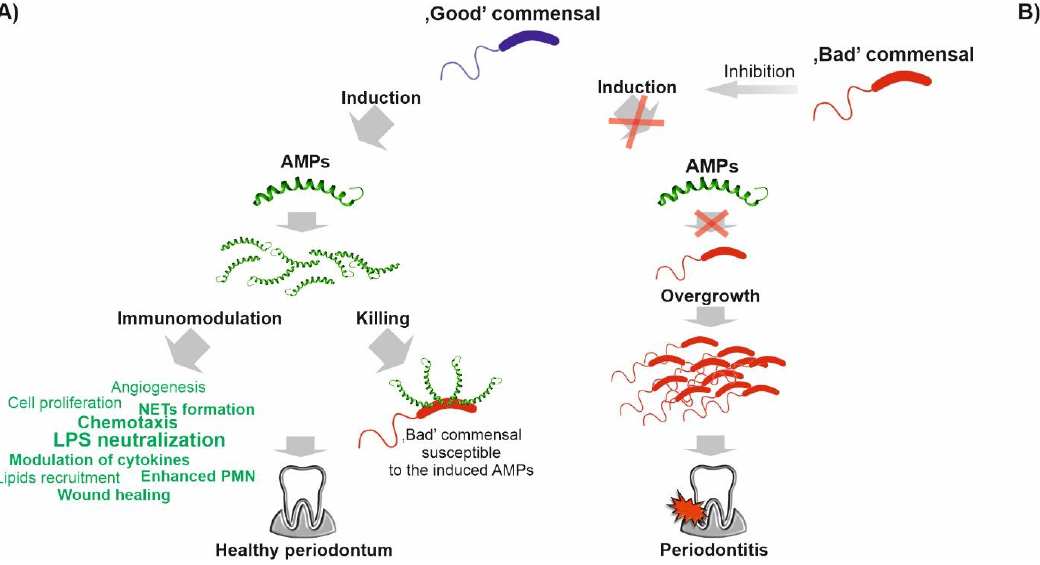
Figure 8. Scenarios of interactions between the oral bacteria and LL-37 and other AMPs. (i) “ G ood” commensals induce AMPs (and are resistant to the induced AMPs), while “bad” commensals are susceptible to the induced AMPs; (ii) “good” commensals, by inducing AMPs, enable the host to protect themselves from potential attack by pathogenic bacteria and to control eubiosis (panel A